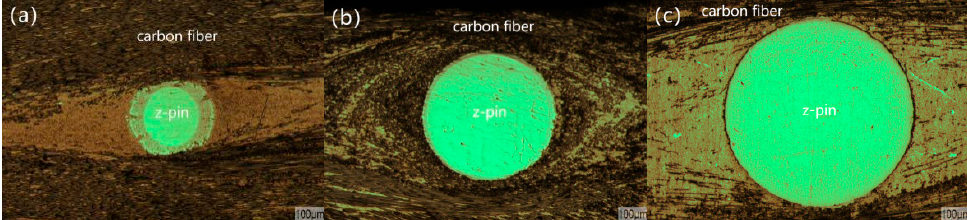
Figure 4. Microstructure of z-pinned Cf/Al composites. ( a ) ϕ 0.3 mm metal pin, ( b ) ϕ 0.6 mm metal pin, and ( c ) ϕ 0.9 mm metal pin.